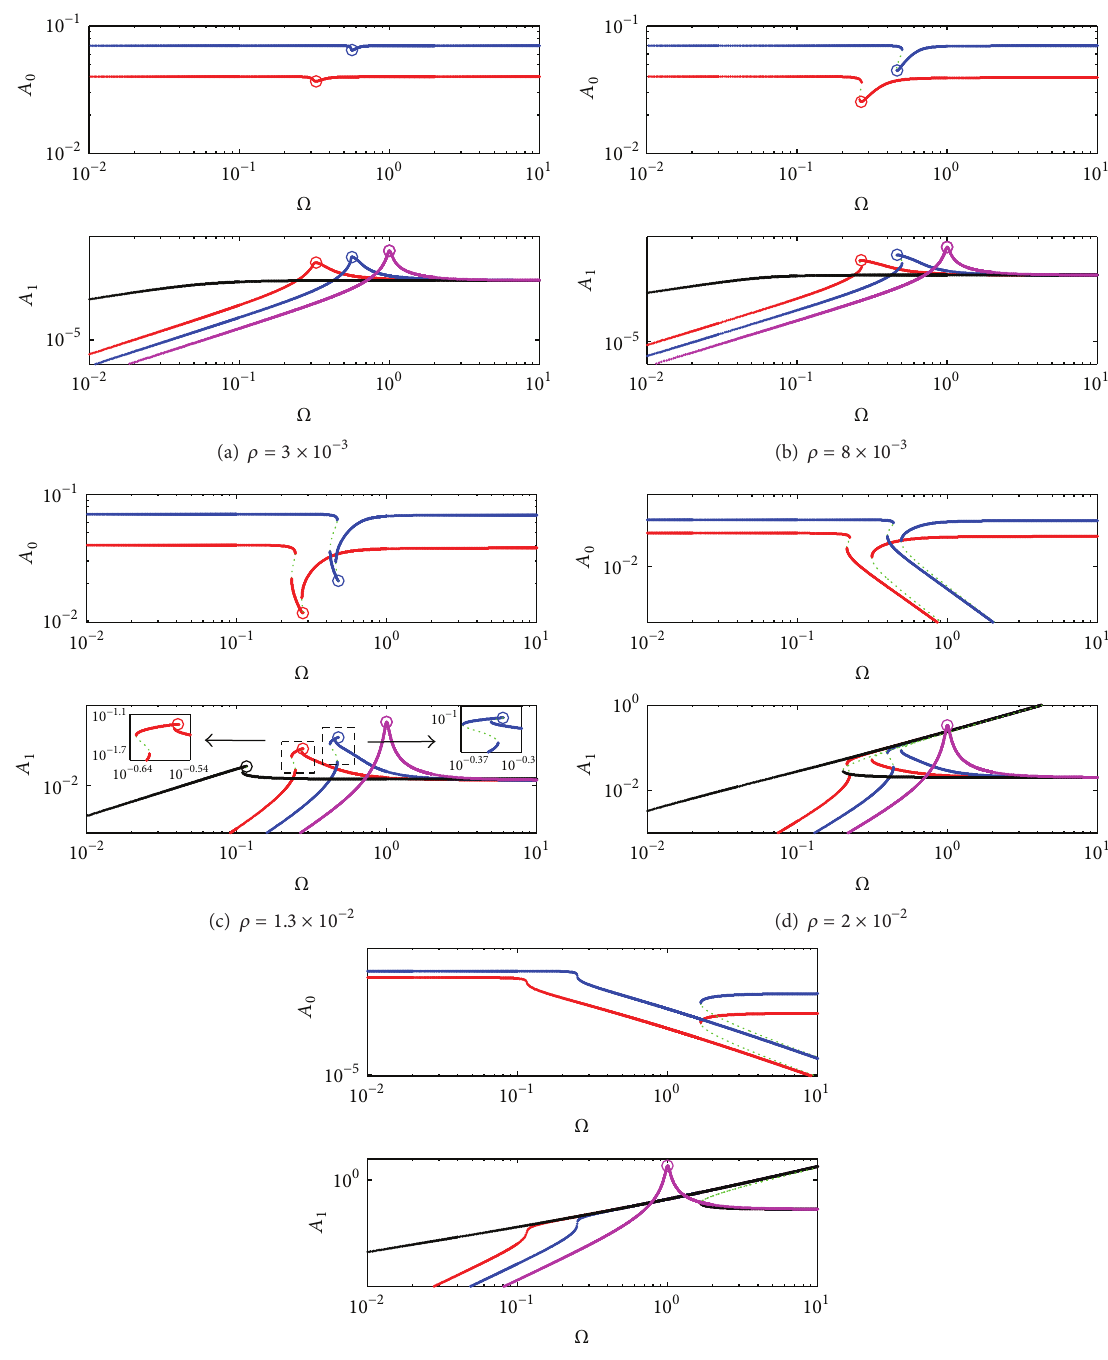
Figure 12: FRCs of the QZS isolator and ELS with different offset displacements and excitation amplitudes for the displacement excitation. “Red line” the disturbed isolator with ̂𝑢 0 = 0.04 ; “blue line” the disturbed isolator with ̂𝑢 0 = 0.07 ; “black line” the ideal system; “magenta line” ELS; “green dotted line” unstable solutions; “o” peak amplitude of